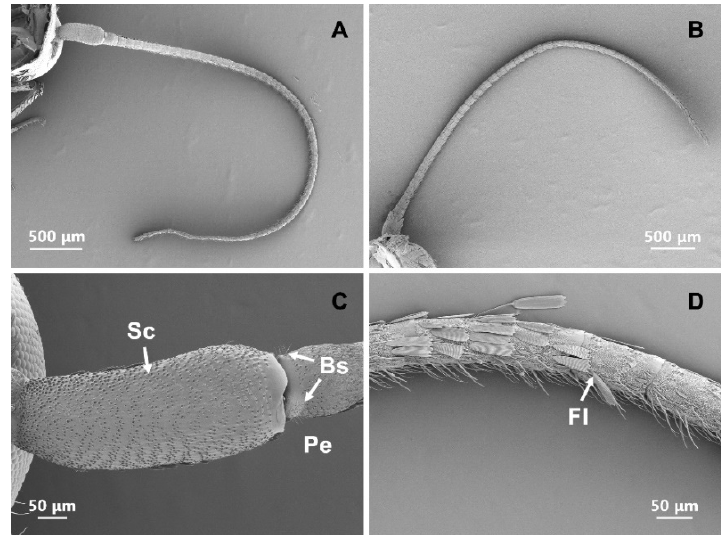
some bumps of varying sizes in the middle of the ridges (Figure 2E).